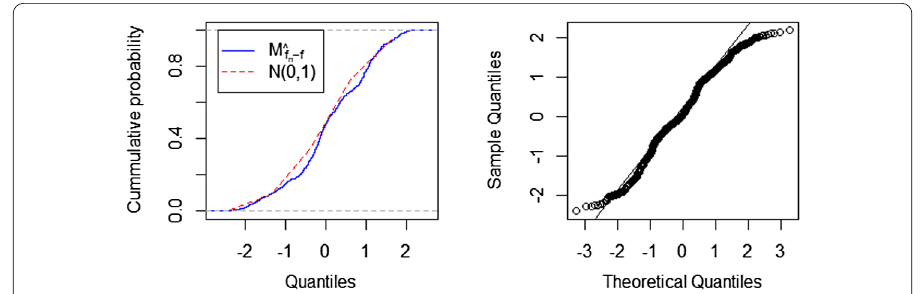
Figure 3 A comparison fitted distribution functions of M ˆ